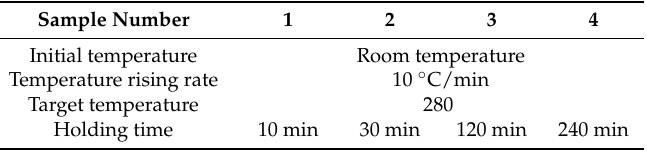
Table 3. Isothermal annealing treatment